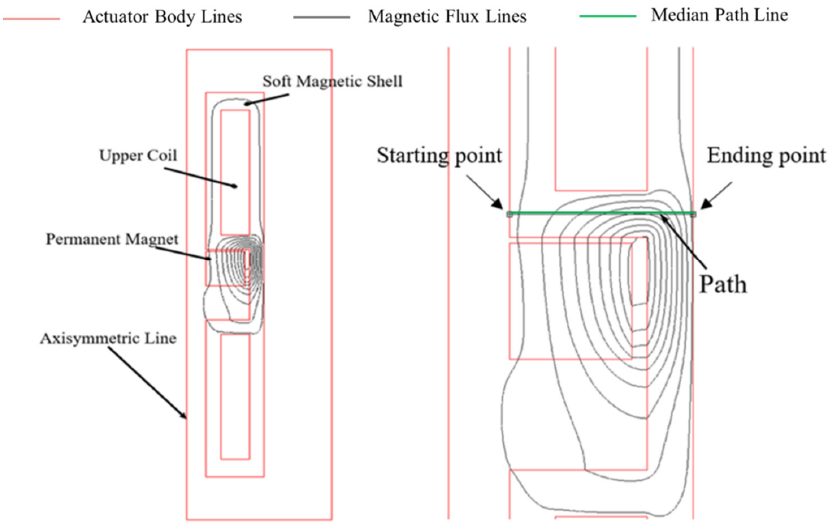
Figure 4. Contour plot of the magnetic flux lines across the actuator body with the imaginary median path shown in the zoomed-in (right side) figure.